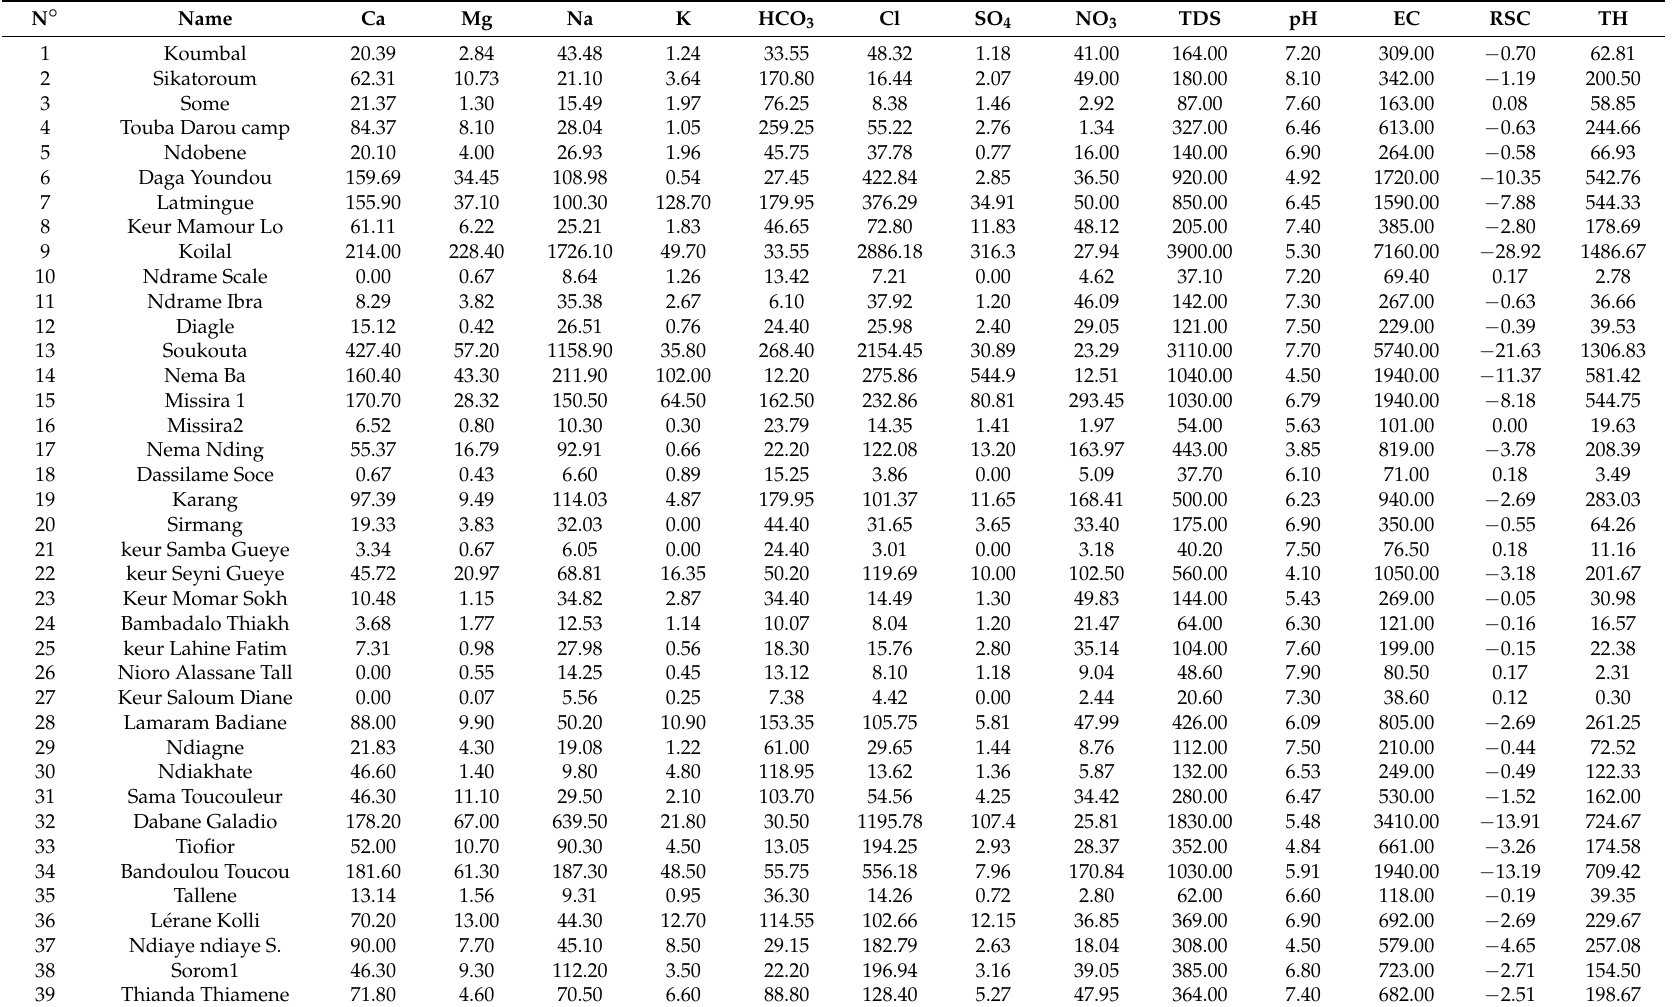
Table 1. Analytical Results of Groundwater Samples from the Saloum CT